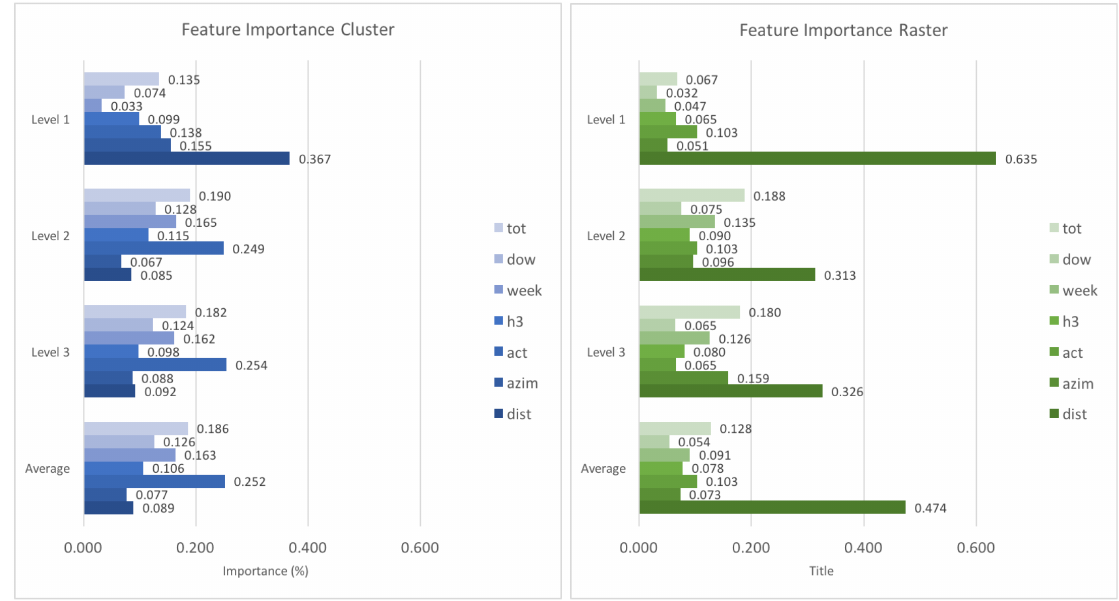
Figure 11. The importance of individual features both for the cluster- and raster-based approach. While the distance dominates in the raster-based setting, the feature importance distribution is more equal in the cluster-based